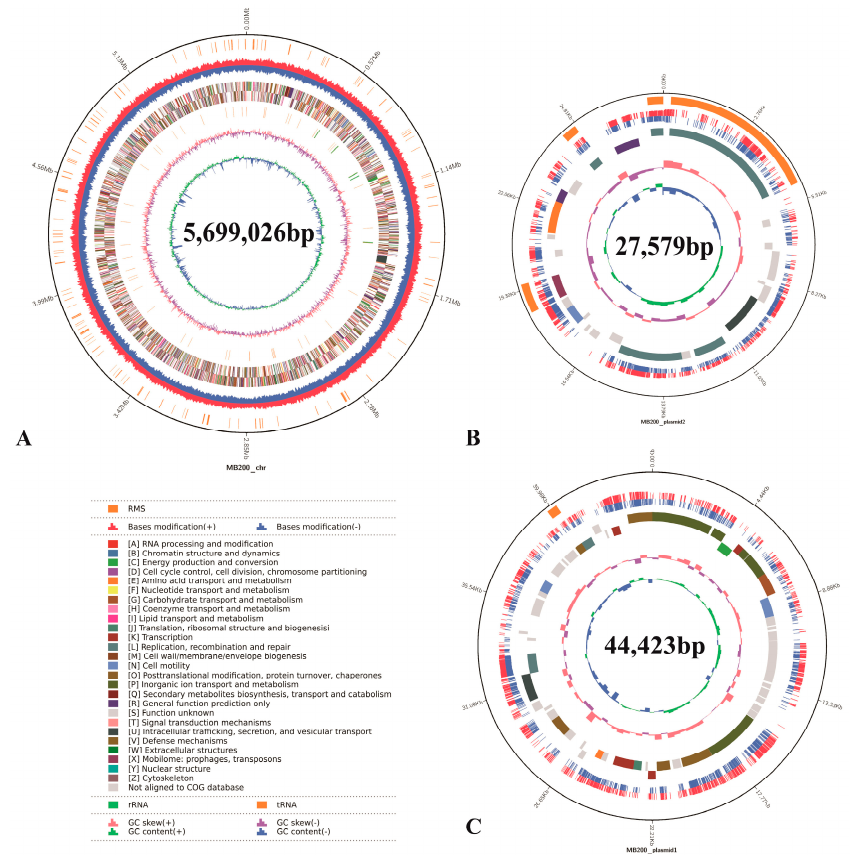
Figure 2. Graphical map of the genome ( A ) and two plasmids ( B , C ) of the strain MB200. Successive circles from the center to outside: 1, GC content; 2, GC skew (positive in pink and negative in